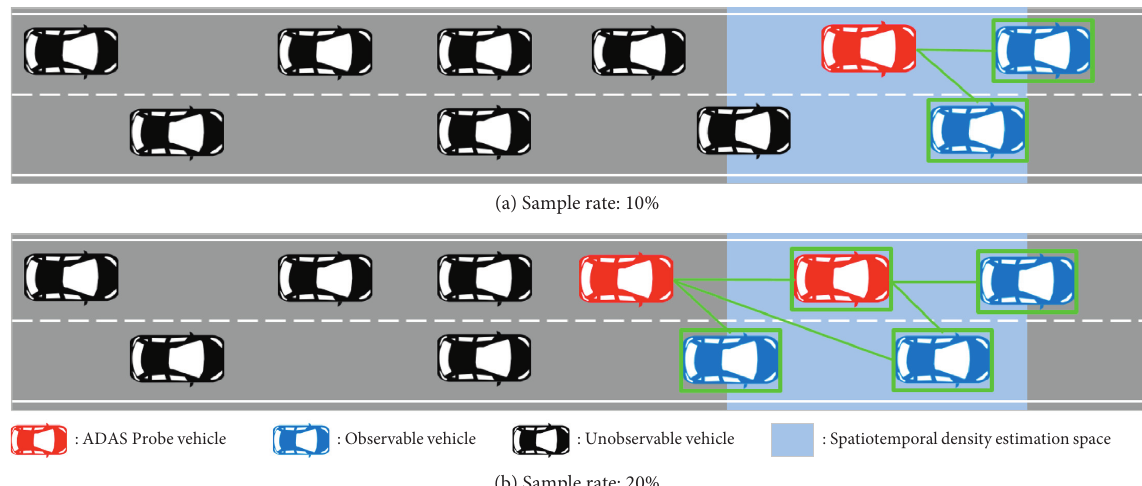
Figure 2: Example of sample rate. (a) Sample rate: 10%. (b) Sample rate: